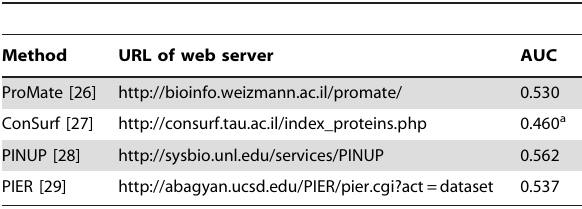
Table 2. List of the protein binding site prediction methods and their obtained AUC